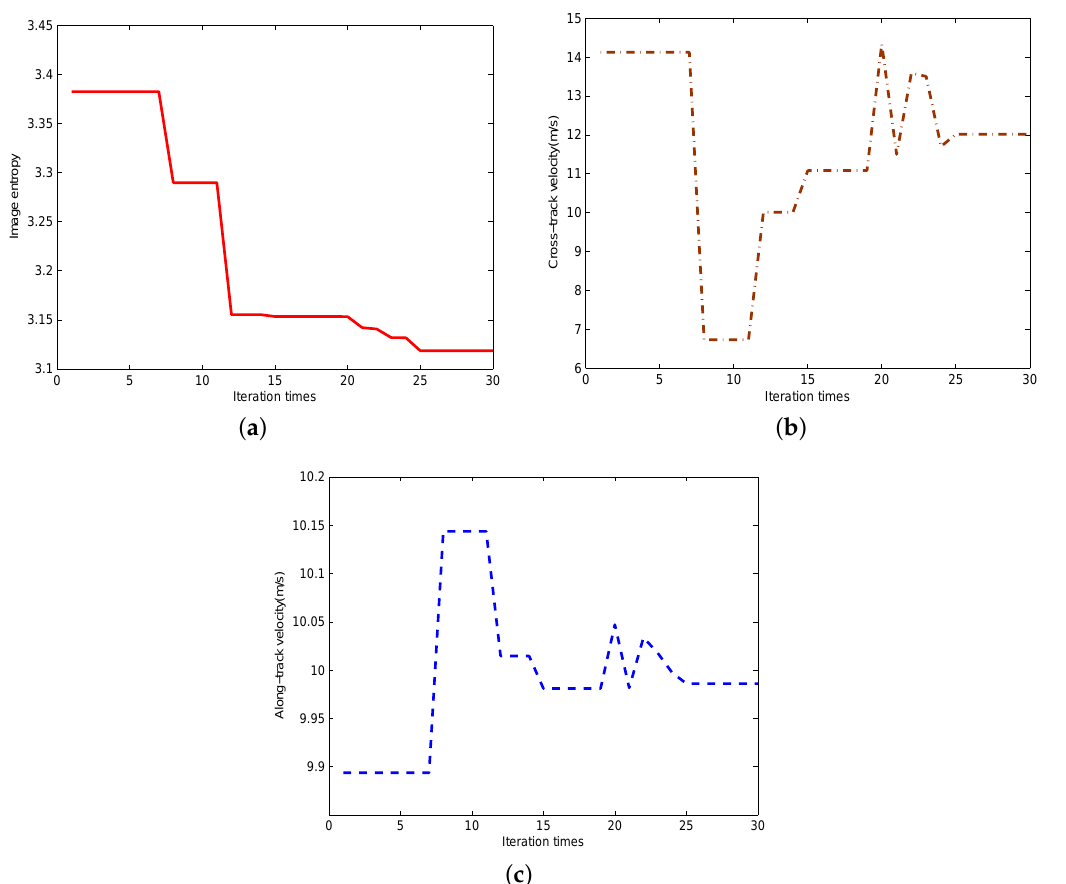
Figure 6. The solving process of the new optimization problem for the moving-target imaging. ( a ) Image entropy; ( b ) Estimated cross-track velocity; ( c ) Estimated along-track velocity.